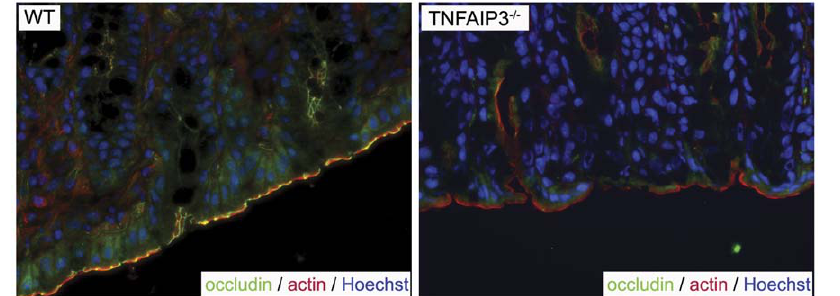
Figure 1. TNFAIP3 supports occludin localization at intestinal tight junctions. Immunohistochemistry for occludin (green), actin (red) and DNA (blue) is shown in intestines of untreated wild type (WT) and TNFAIP3 2 / 2 mice. A lack of typical perijunctional occludin localization can be observed at the apical surface of epithelial cells in the TNFAIP3 deficient mice.